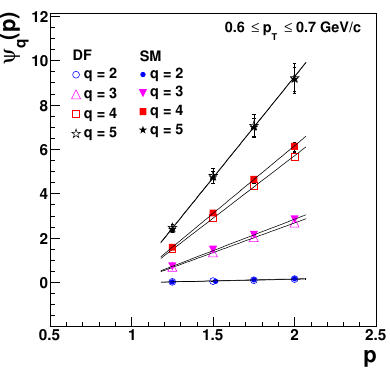
0.5 p Figure 8. ψ q defined in Equation (62) as a function of the momentum in intermittency study for the p ⊥ window 0.6 ≤ p ⊥ ≤ 0.7GeV, cf. ref.